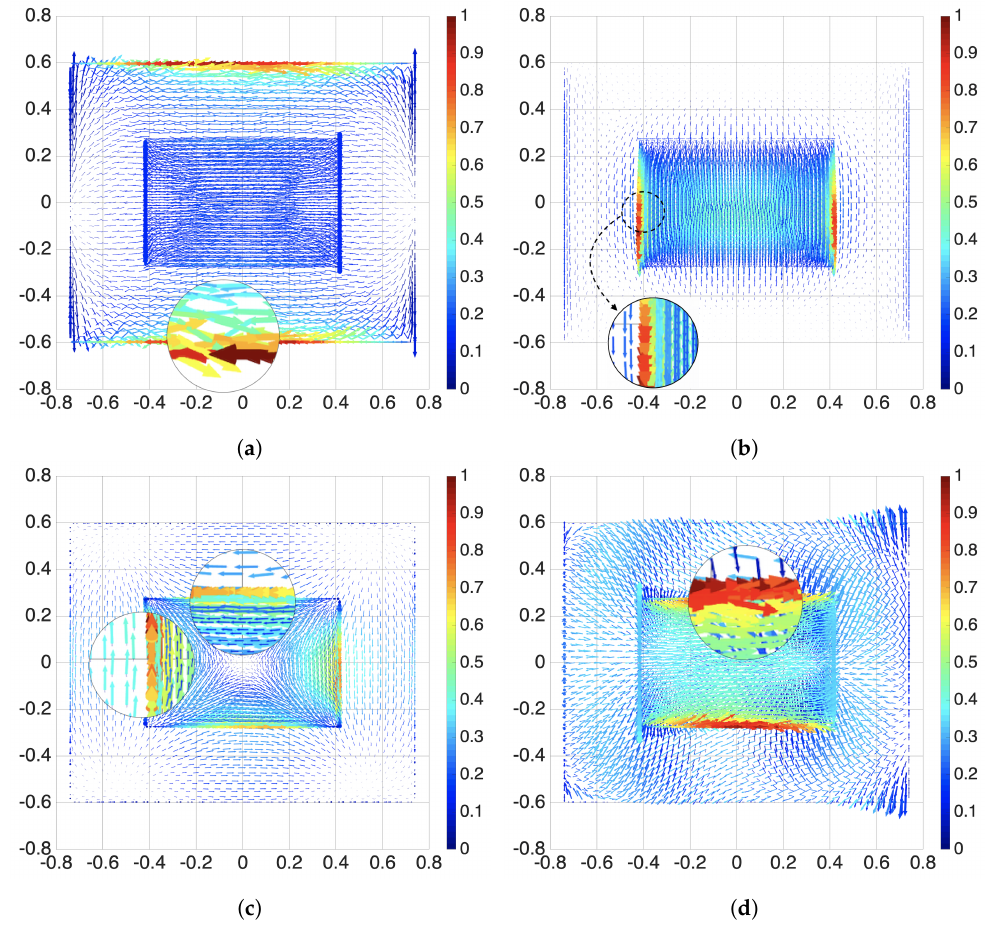
Figure 11. Electric current density J for modes f rA ( a ) #1, ( b ) #4, ( c ) #5, and ( d ) #10 of Table 1, flowing on the metallic portions of the patch antenna, i.e., the top isle and the ground.